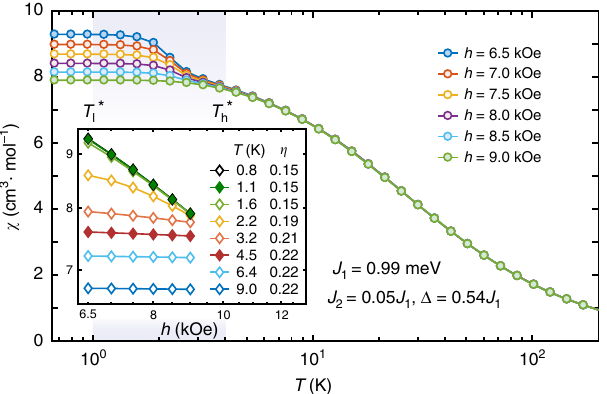
Fig. 3 Algebraic scaling of uniform magnetic susceptibility. At high temperature T ≳ 4K, χ ( h , T ) remains independent of h for small fi elds, which indicates an exponent of α = 0 in χ ( h , T ) ~ h − α ( T ) , whereas for 1K ≲ T ≲ 4K (shaded regime), χ ( h , T ) exhibits an universal scaling vs. h with α ≠ 0. For (cid:4) 1 K, the susceptibility ceases to increase as the temperatures below T (cid:3) l system orders into the clock phase. In the inset, χ ( h , T ) vs. h curves are presented in the log – log plot, where the algebraic scaling manifests itself in the KT phase (and in the clock phase due to the saturation). The fi tted η values decrease from 2/9 gradually to ~0.15, the deviation of the latter from the expectation of 1 ∕ 9 is ascribed to limited lattice size ( L = 12 torus) adopted in the QMC